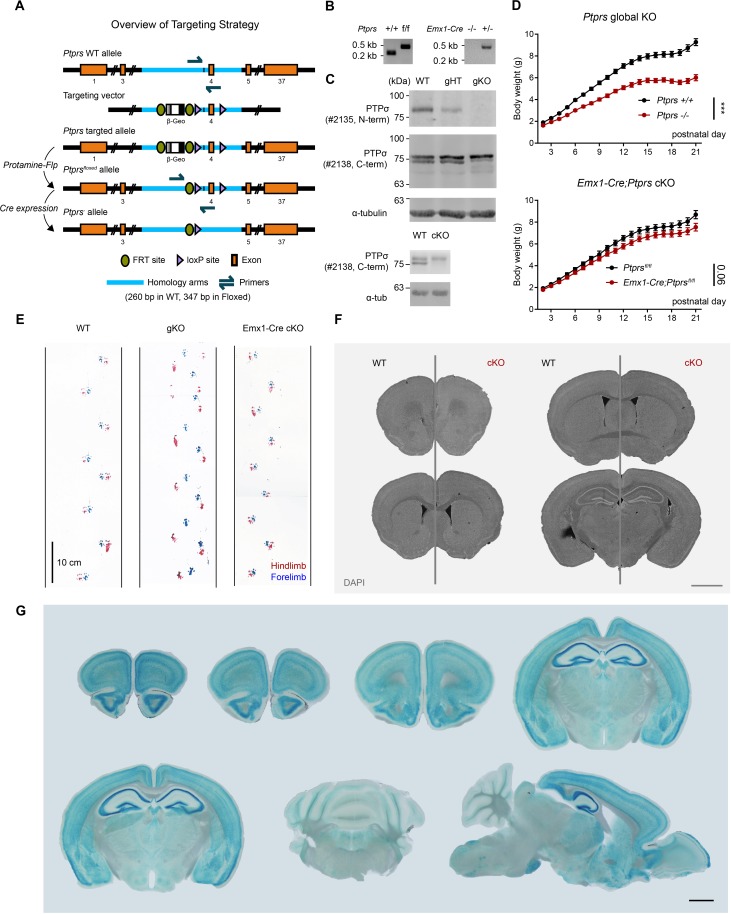
Generation and basic characterization of global Ptprs-mutant mice and Emx1-Cre;Ptprsfl/fl mice.(A) Conditional KO strategy for the production of Emx1-Cre;Ptprsfl/fl cKO mice. (B) PCR genotyping of Ptprsfl/fl and Emx1-Cre alleles. (C) Reduced levels of PTPσ proteins in hippocampal lysates of global Ptprs-mutant mice (gHT/Ptprs+l–, heterozygotes; gKO/Ptprs–l–, homozygotes) and Emx1-Cre;Ptprsfl/fl cKO mice at P21, compared with WT and Ptprsfl/fl mice, as revealed by immunoblot analyses using anti-PTPσ antibodies directed against N-terminal (Ig1+two domains) and C-terminal (last 30 aa residues) regions of the PTPσ protein. A non-specific band recognized by the C-terminal antibody is indicated by an asterisk. (D) Reduced body weights of global Ptprs-mutant mice, but largely normal body weights of Emx1-Cre;Ptprsfl/fl mice, during the first three postnatal weeks. (n = 37/10 mice for WT/gKO, 22/23 mice for WT/cKO, ***p<0.001, two-way ANOVA with Sidak’s test). (E) Abnormal walking patterns in Ptprs-mutant mice, but normal walking patterns of Emx1-Cre;Ptprsfl/fl mice, as revealed by monitoring the walking of mice with painted feet (blue, fore; red, hind) on paper. (F) Normal gross morphology of the brain of Emx1-Cre;Ptprsfl/fl mice (8 weeks), as shown by DAPI staining. Scale bar, 2 mm. (G) Distribution patterns of PTPσ–β-galactosidase fusion proteins, as revealed by X-gal staining of coronal brain slices from WT mice targeted with the β-geo + Ptprs flox vector (8 weeks). Scale bar, 2 mm.